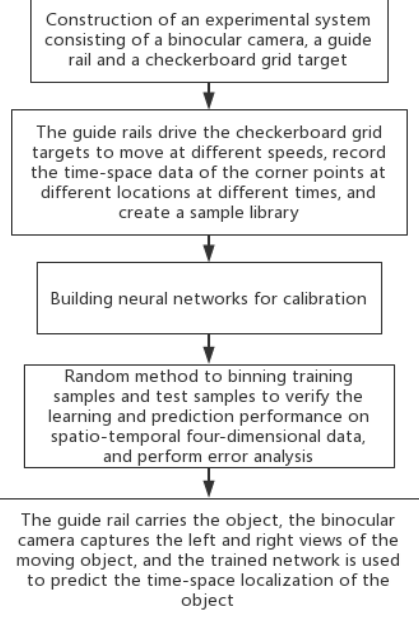
Figure 3. Predictive model flowchart.